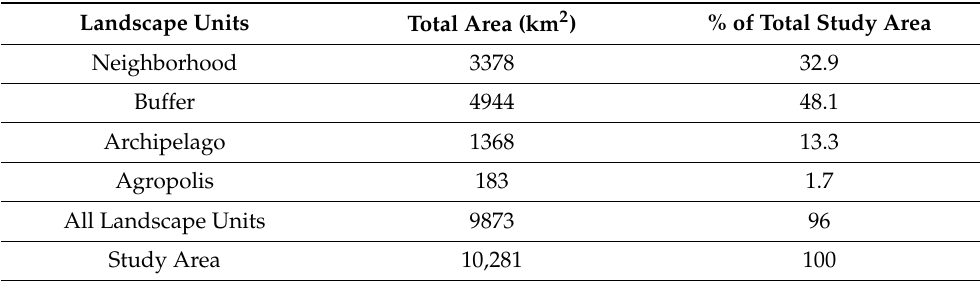
Table 4. The total area of each landscape category, compared to the total size of the study area. While an area equal to 96% of the study area was classified, this figure does not account for overlap between